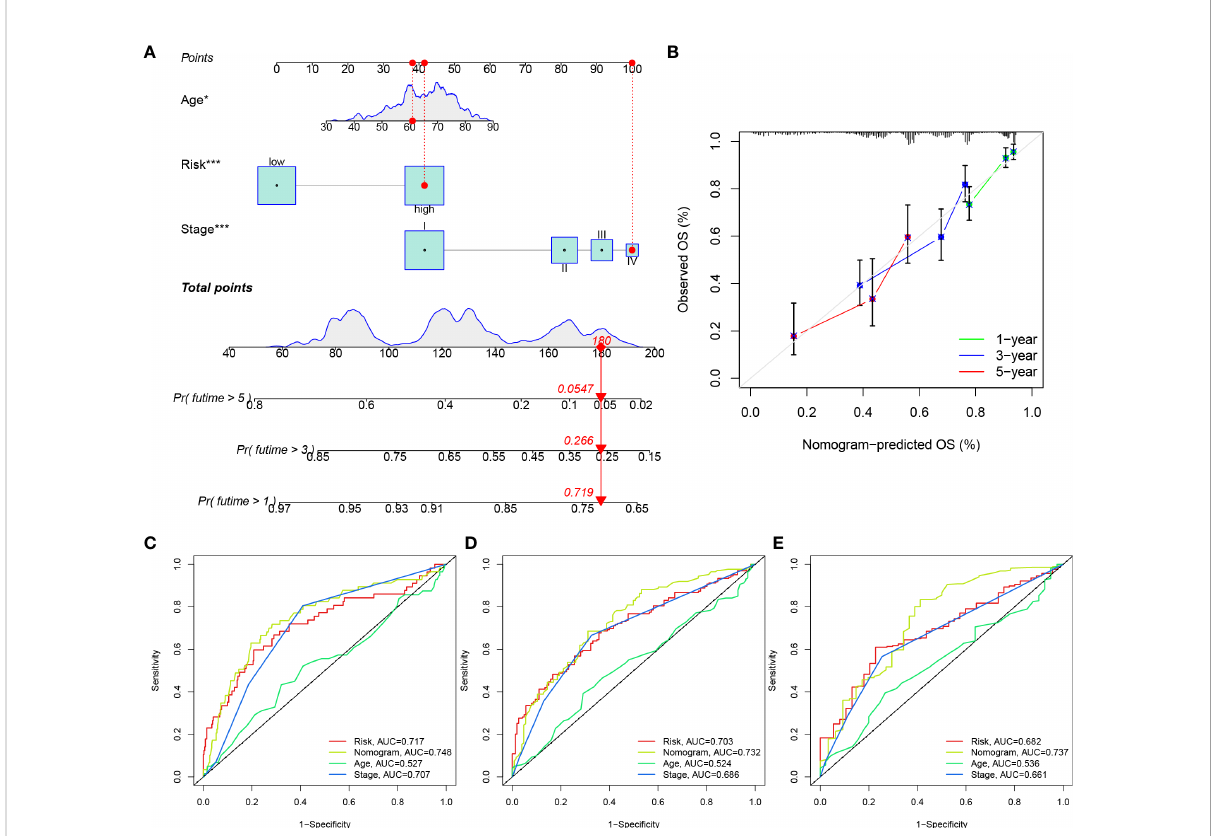
FIGURE 11 Construction of a nomogram. (A) Construction of a nomogram based on risk, age and stage. (B) Calibration curves of the nomogram in predicting OS of TCGA-LUAD patients. ROC curves of the nomogram, risk, stage and age in predicting 1 year- (C) , 3 years- (D) and 5 years- (E) OS of TCGA-LUAD